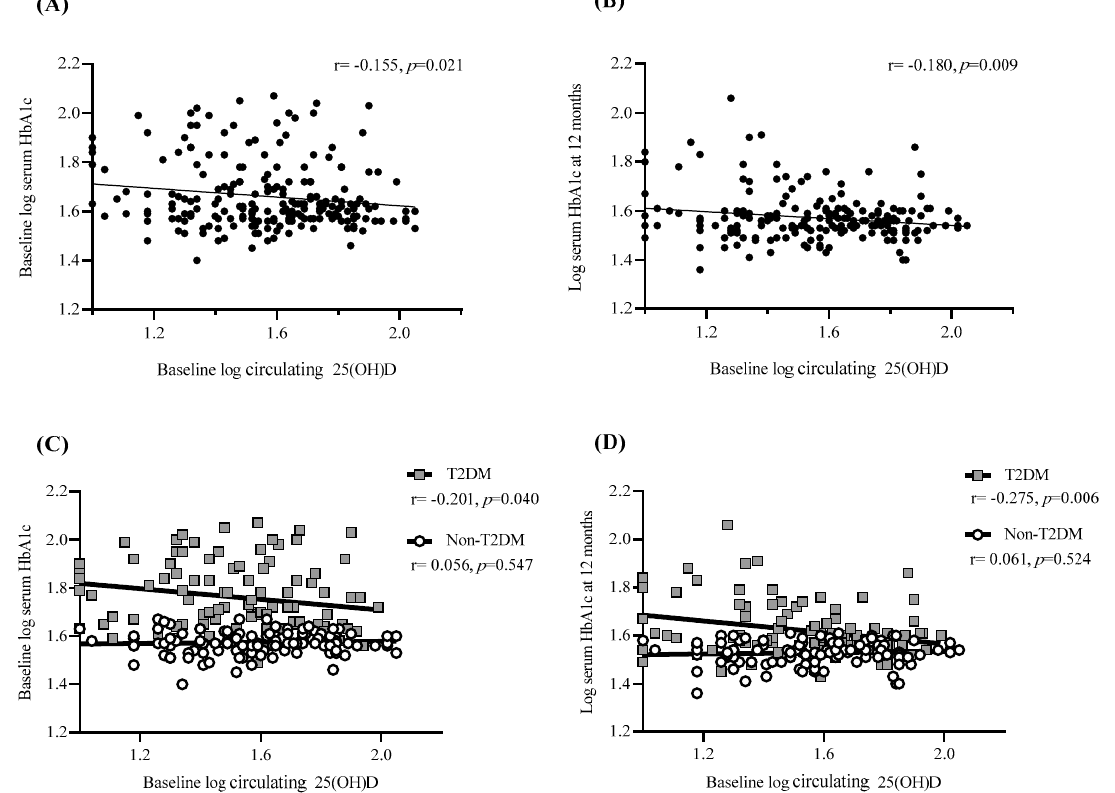
Figure 4. Association of 25(OH)D levels with weight regain and pre/post-surgical HbA1c. Scatter plot showing the correlation between ( A ) baseline 25(OH)D levels and baseline HbA1c for total cohort ( n = 223), ( B ) baseline 25(OH)D levels and HbA1c levels at one-year post-surgery for total cohort ( n = 209) ( C ) baseline 25(OH)D levels and baseline HbA1c depending on T2DM status ( n = 105 for T2DM and n = 118 for non-T2DM)) and ( D ) baseline 25(OH)D levels and HbA1c levels at one-year post-surgery depending on T2DM status ( n = 98 for T2DM and n = 111 for non-T2DM)). Linear trend line is shown with Pearson correlation statistic (r) and significance ( p ). p is considered significant if <0.05. Data were log-transformed prior to correlation analysis to improve normality.